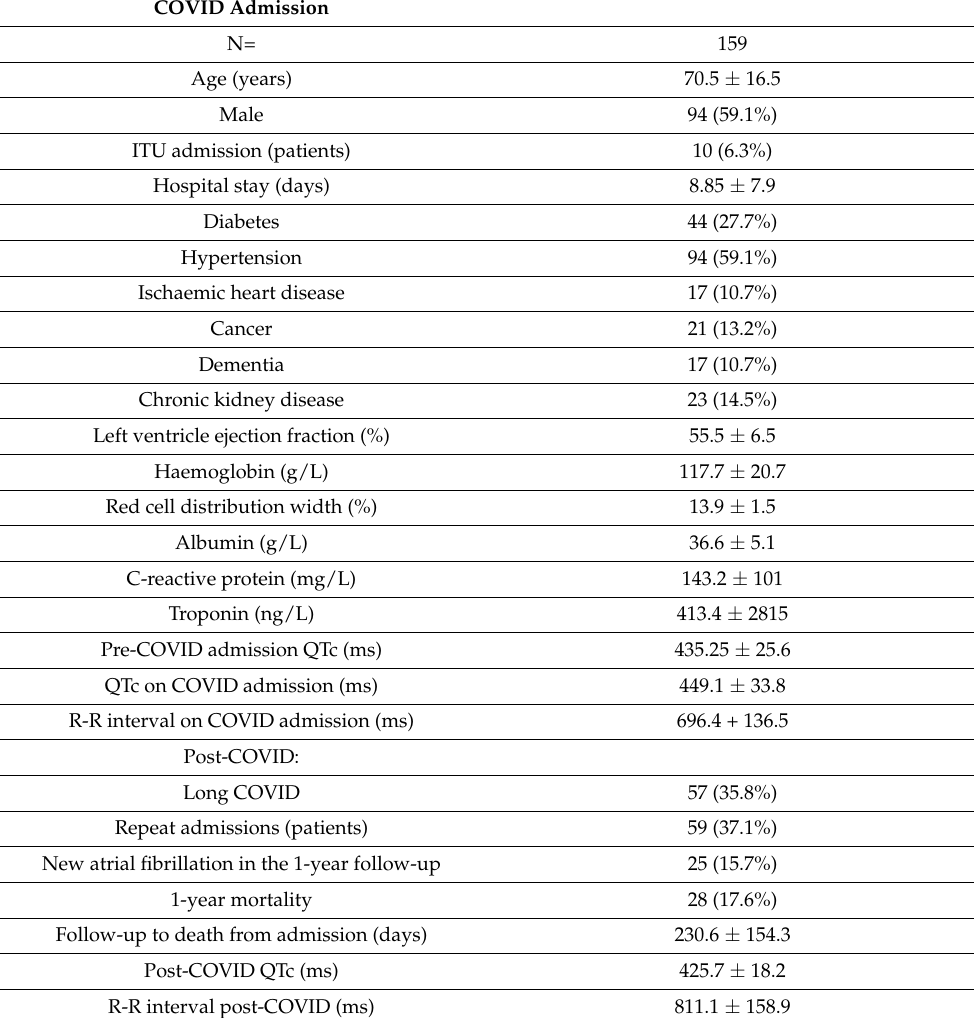
Table 1. Overall demographics of patients who had survived the index COVID-19 illness, including post-COVID